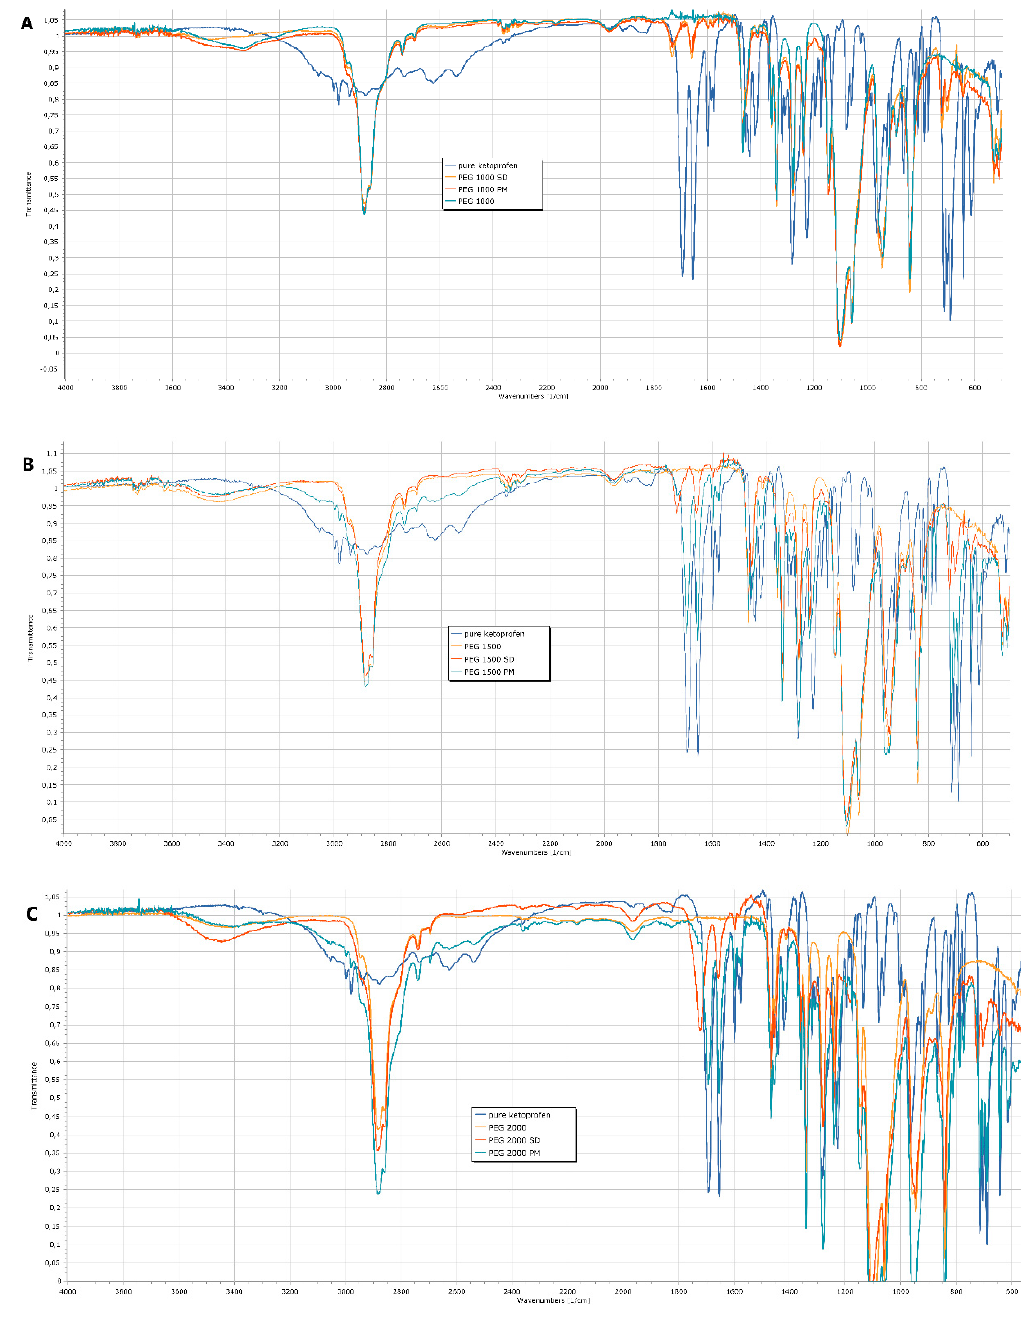
Figure 2. FT-IR spectra of ketoprofen, pure PEGs, physical mixtures (PM), solid dispersions (SD) for PEG 1000 ( A ), PEG 1500 ( B ), and PEG 2000 ( C ). The intensity peaks were normalized for the highest intensity peak.